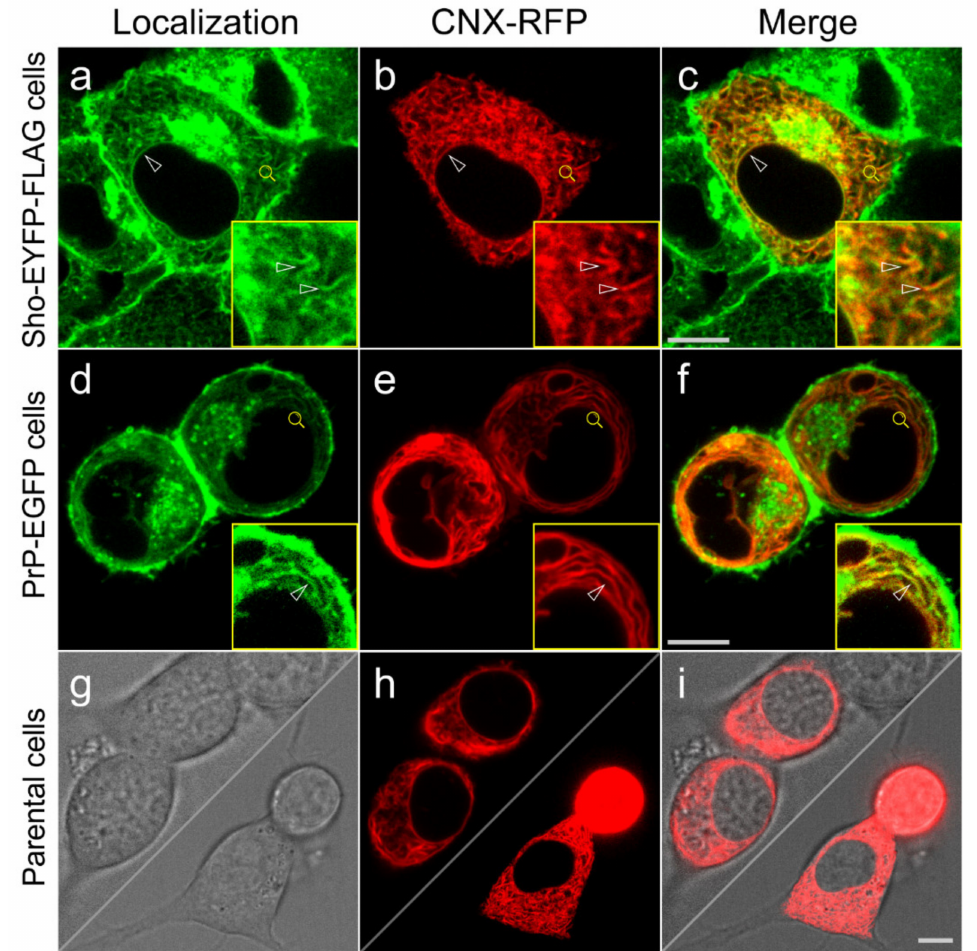
Figure 5. Live-cell analysis shows colocalization of Shadoo and prion proteins with calnexin in the ER membrane network. Stable transgenic Sho-EYFP-FLAG ( a – c ) and PrP-EGFP ( d – f ) cells expressing EYFP-FLAG-tagged Sho and EGFP-tagged PrP (green), respectively, and parental N2a cells ( g – i ) are transiently transfected to express red fluorescent protein (OFPSpark)-tagged calnexin (CNX-RFP, ( g – i ), red). Merged images from the green and red channels show the overlapping fluorescence in yellow. Insets show representative ER areas corresponding to positions of the magnifying glass symbols, magnified and with intensity enhancement for better visualization. Arrowheads point to examples of areas with colocalization. Scale bar: 10 µ